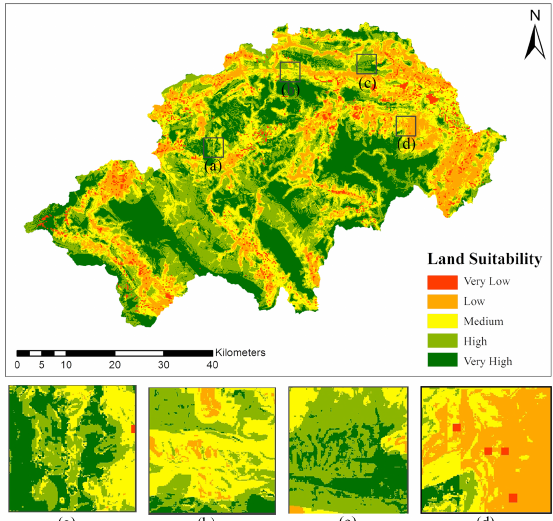
Figure 5. The erratic “islands” in the land suitability map of Shennongjia Forest